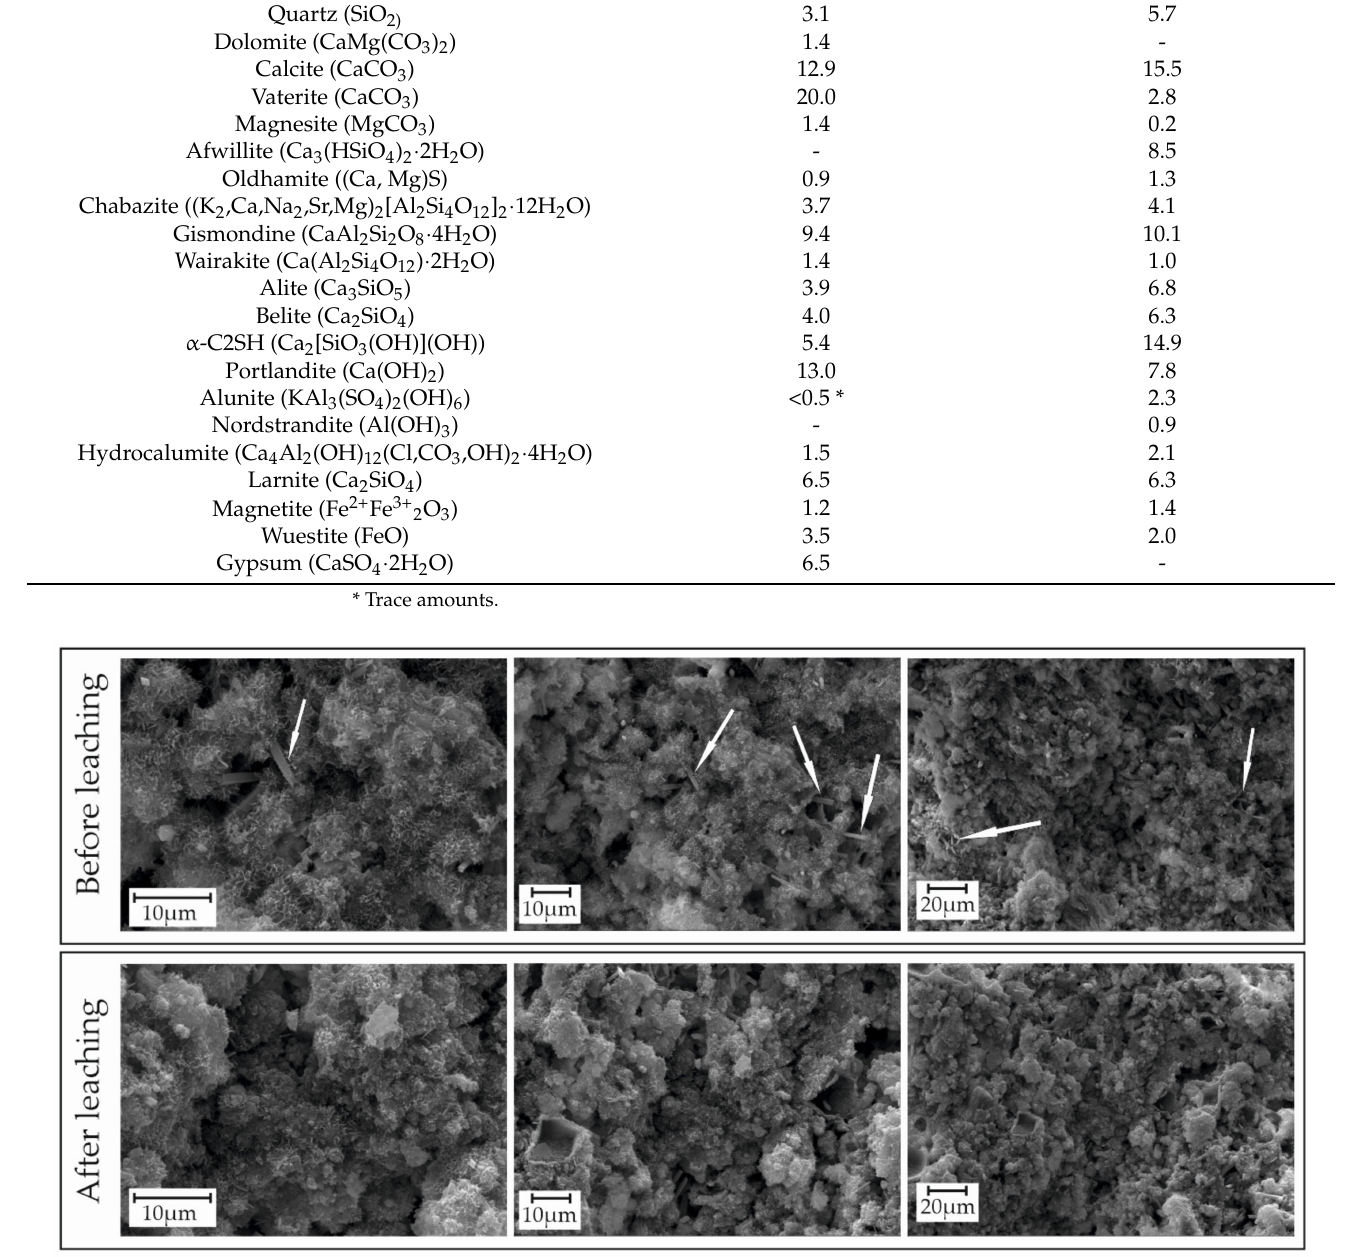
Figure 5. SEM images of concrete sample (before leaching—unchanged central zone, after leaching— altered marginal zone). Arrows mark